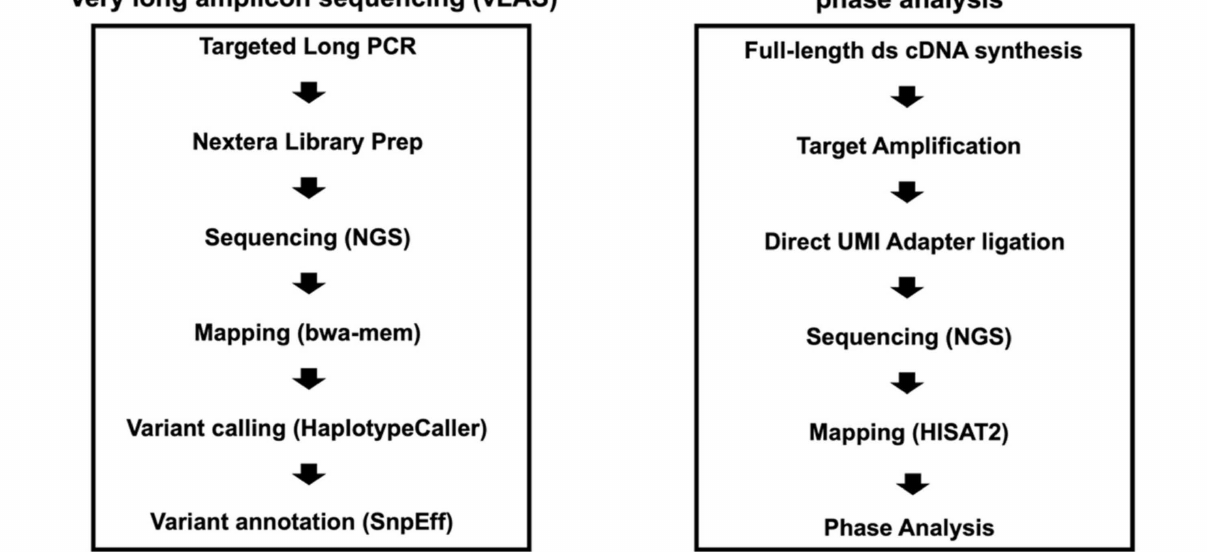
Figure 1. ( A ) Workflow for targeted double-stranded cDNA sequencing-based phase analysis. Types of compound heterozygous mutations ( in cis and in trans ); ( B ) Scheme of in trans compound heterozygous mutations on genomic DNA and mRNA; ( C ) Workflow for the detection of variants by very long amplicon sequencing (vLAS) and targeted double-stranded cDNA sequencing-based phase